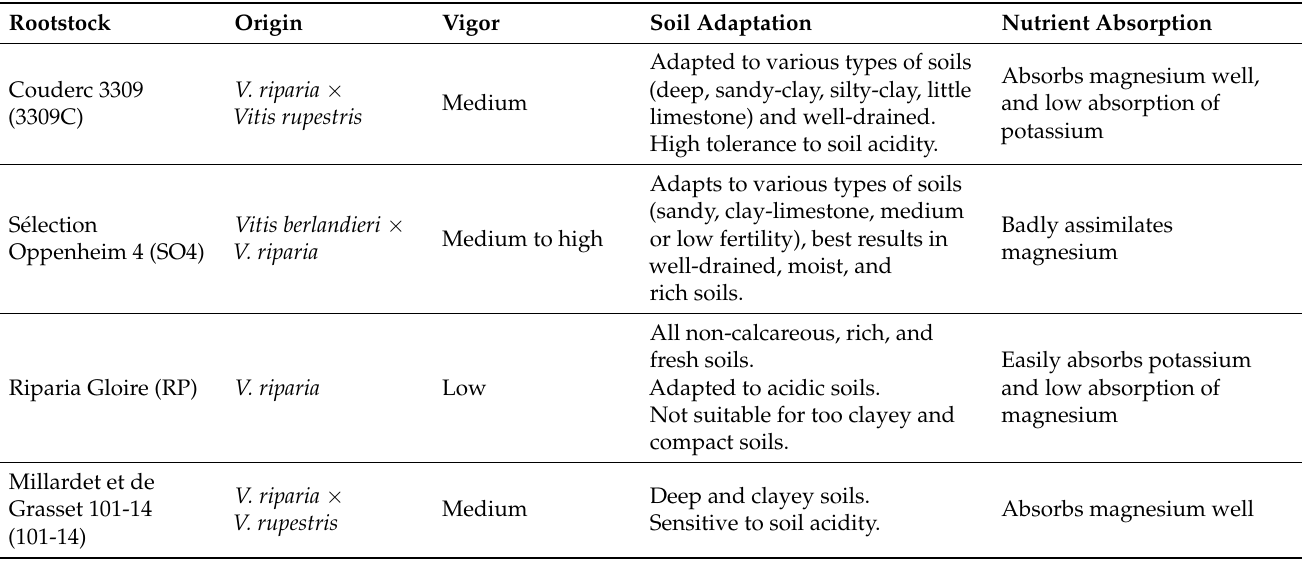
Table 2. Characteristics of